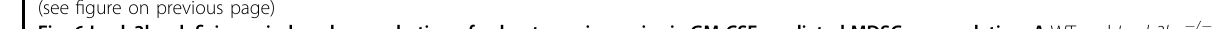
mice were treated with AOM (10 mg/kg). After 5 days of AOM administration, WT ( n = 9) and Lgals3bp − / − ( n = 9) mice were subjected to two DSS cycles. Mice were sacri fi ced at day 50 following AOM injection. WT ( n = 6) and Lgals3bp − / − ( n = 6) mice were subjected to one DSS cycle. Mice were sacri fi ced at day 12 following AOM injection. WT ( n = 9) or Lgals3bp − / − ( n = 9) mice provided with water served as controls. Protein extracts of colons from WT and Lgals3bp − / − mice were analyzed for TAK1, NF- κ B, and I κ B activation via western blotting. B Densitometric analysis of band